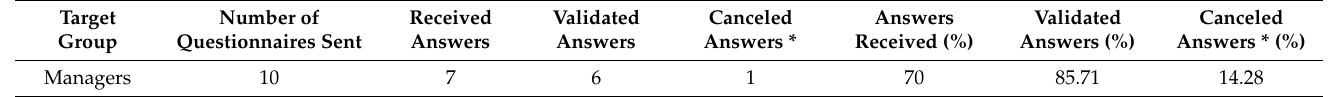
Table 4. Questionnaire analysis.